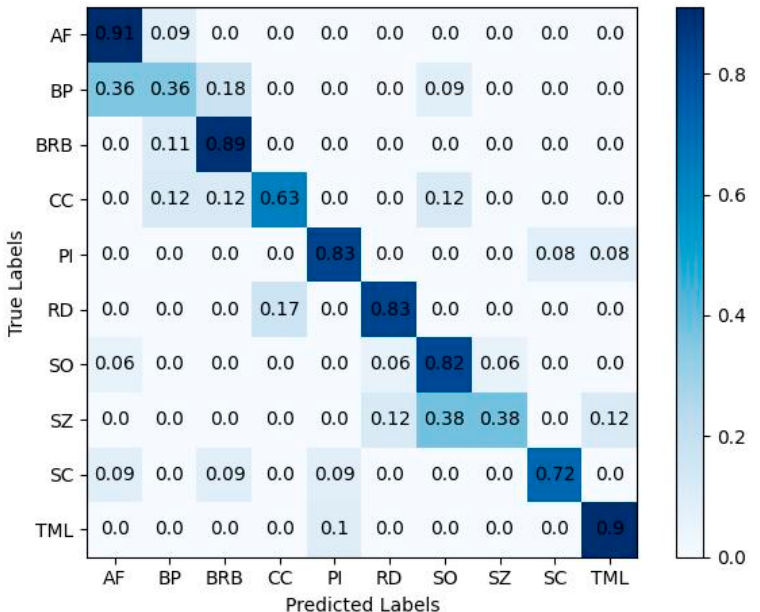
Figure 6. Confusion matrix of the proposed method. The vertical axis is the true label, and the hor-